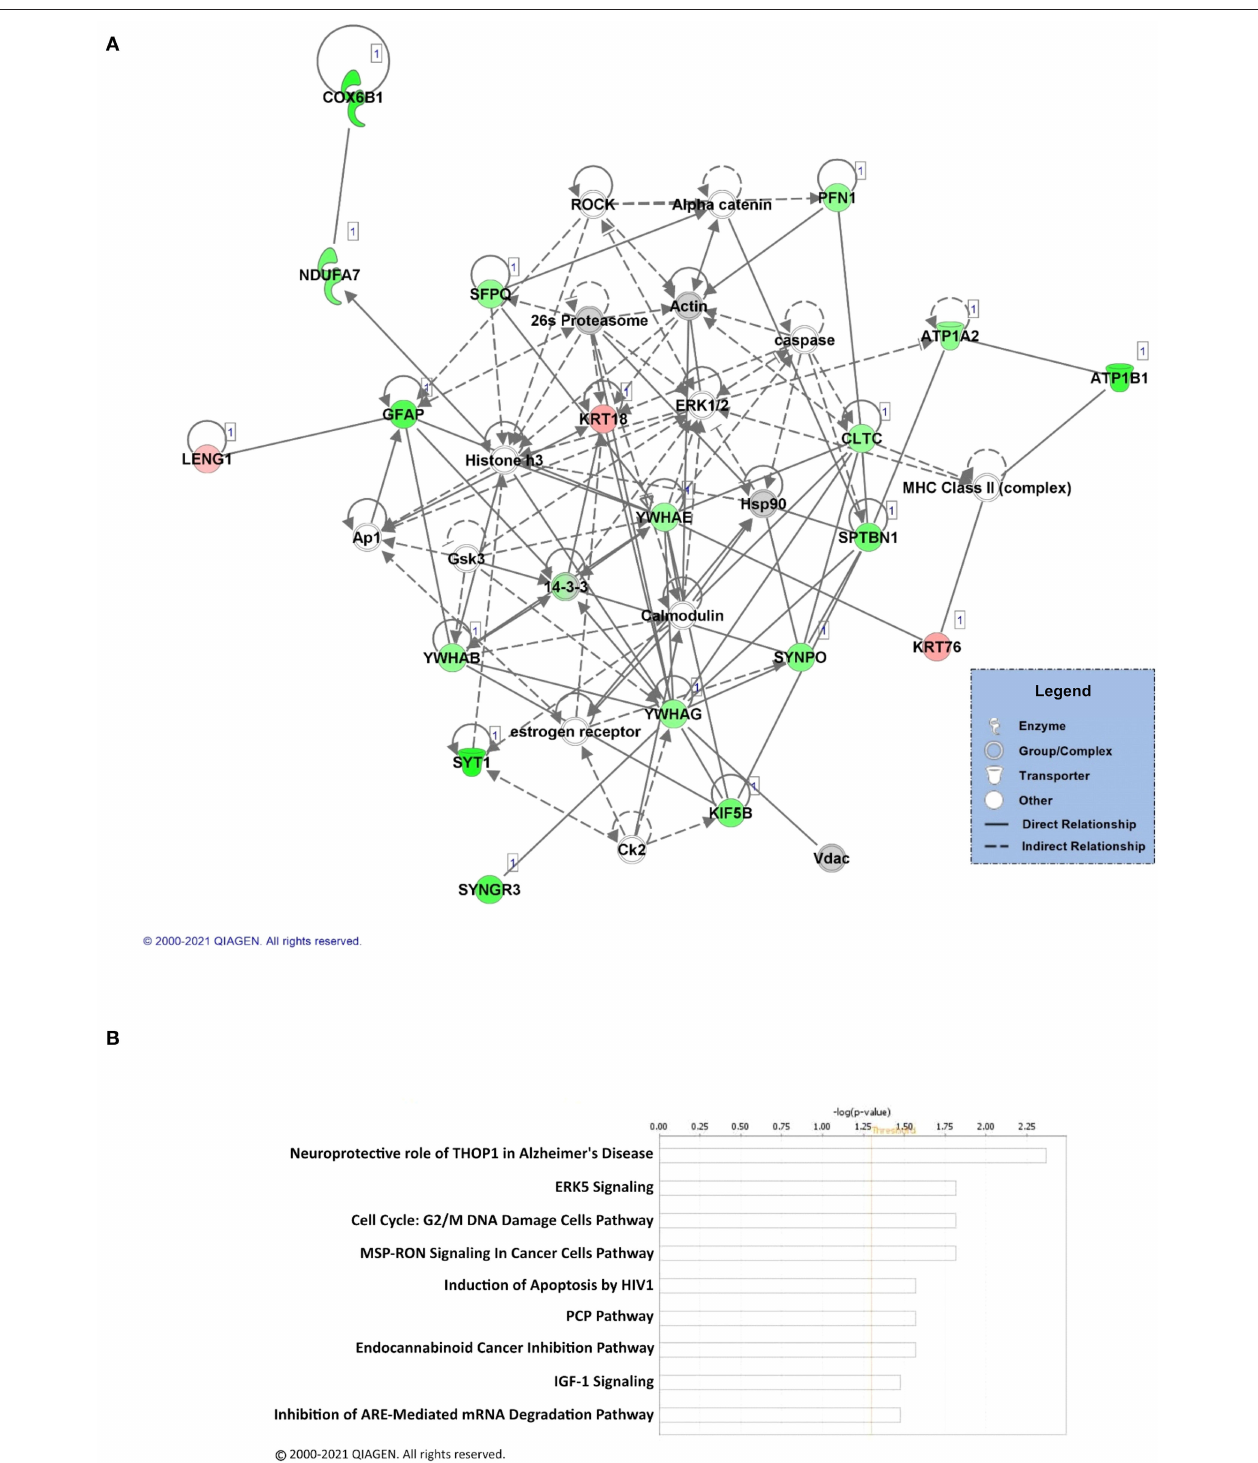
FIGURE 4 | Pathway and network analysis of proteins regulated by K48 polyubiquitin in the amygdala of males. (A) Network of associated proteins with a high fold change ratio of K48 polyubiquitin targeting in males was created using IPA. The proteins with lower levels in K48-purified samples 1 h after training are shown in green and those that had enhanced levels are shown in red. Greater fold-changes have brighter colors. Solid lines indicate a direct relationship while dotted lines refer to indirect relationships between the proteins. (B) The top canonical pathways associated with the altered K48 polyubiquitin targets after the training in the male amygdala and their corresponding score (-log[p value]). A white bar indicates that there is no clear signal for activation or inhibition.